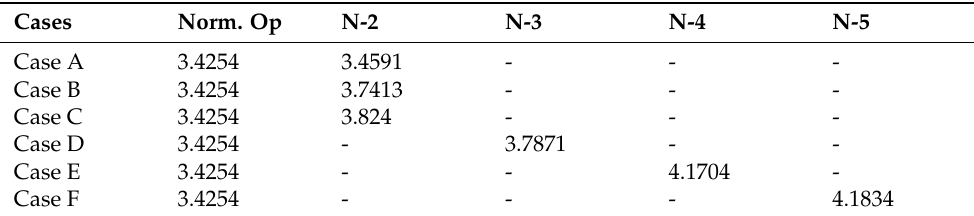
Table 3. Contingency indexes for cases A, B, C, D, E, and F in the IEEE 118 bus system.